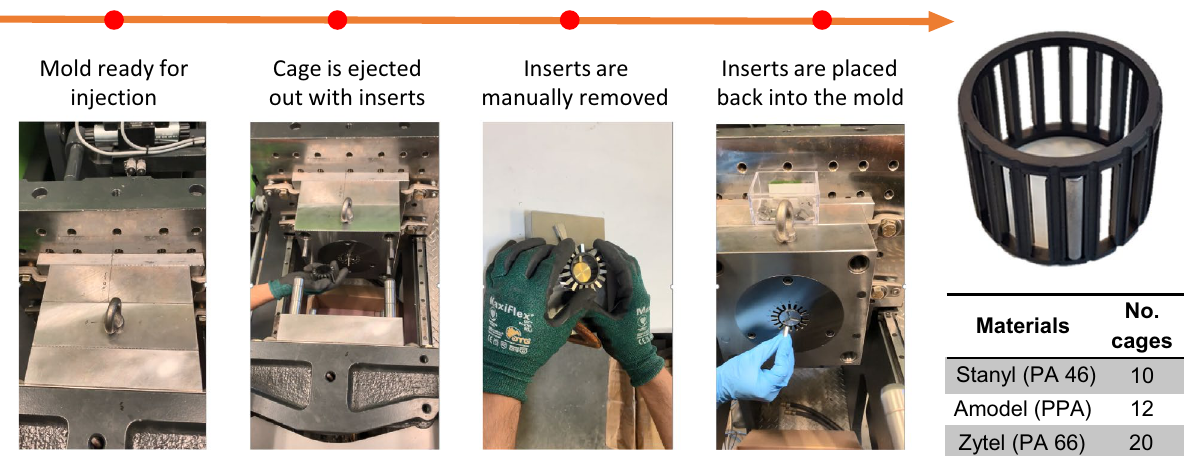
Figure 4. The procedure of manufacturing the polymeric cages and the final number of the molded parts for each material.